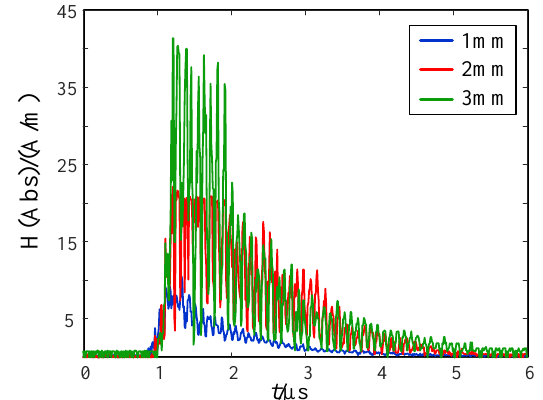
Figure 11. Synthetic magnetic field strength.